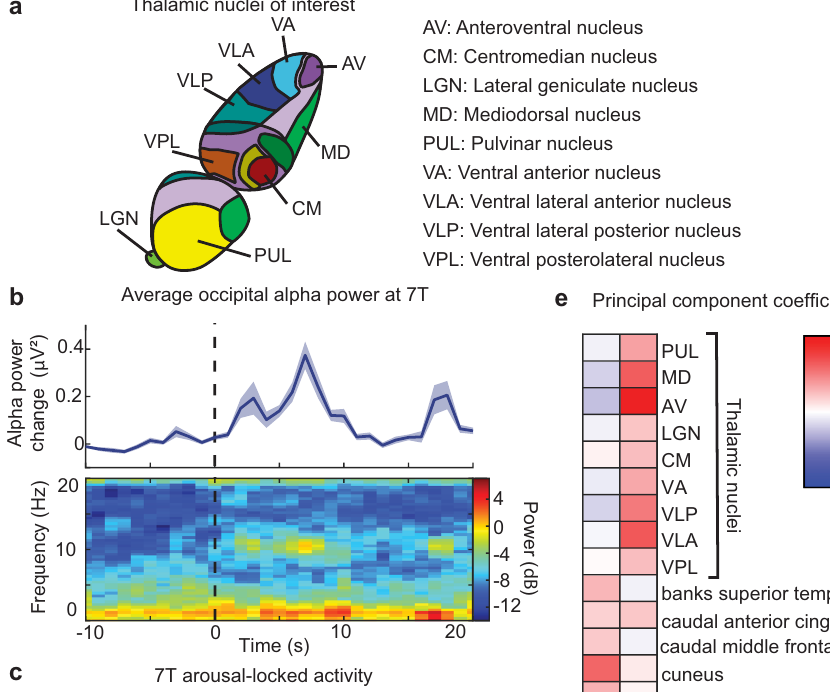
Fig. 3 | 7T imaging shows two primary activity modes at behavioral arousal, largely segregated into thalamic activation and cortical deactivation. a Schematic of the thalamic nuclei of interest that were resolved with this imaging protocol.ThisimagewascreatedbytheauthorsandwasinspiredbytheAllenBrain Atlas 131 . b In one subject scanned with simultaneous EEG ( n =6 arousals), mean alpha power signi fi cantly increases during behavioral arousal (dashed line), con- sistentwithExperiment1.Shadingisastandarderror. c Experiment2replicatesthe result that the thalamus activates (20% latency indicated by red arrow) prior to